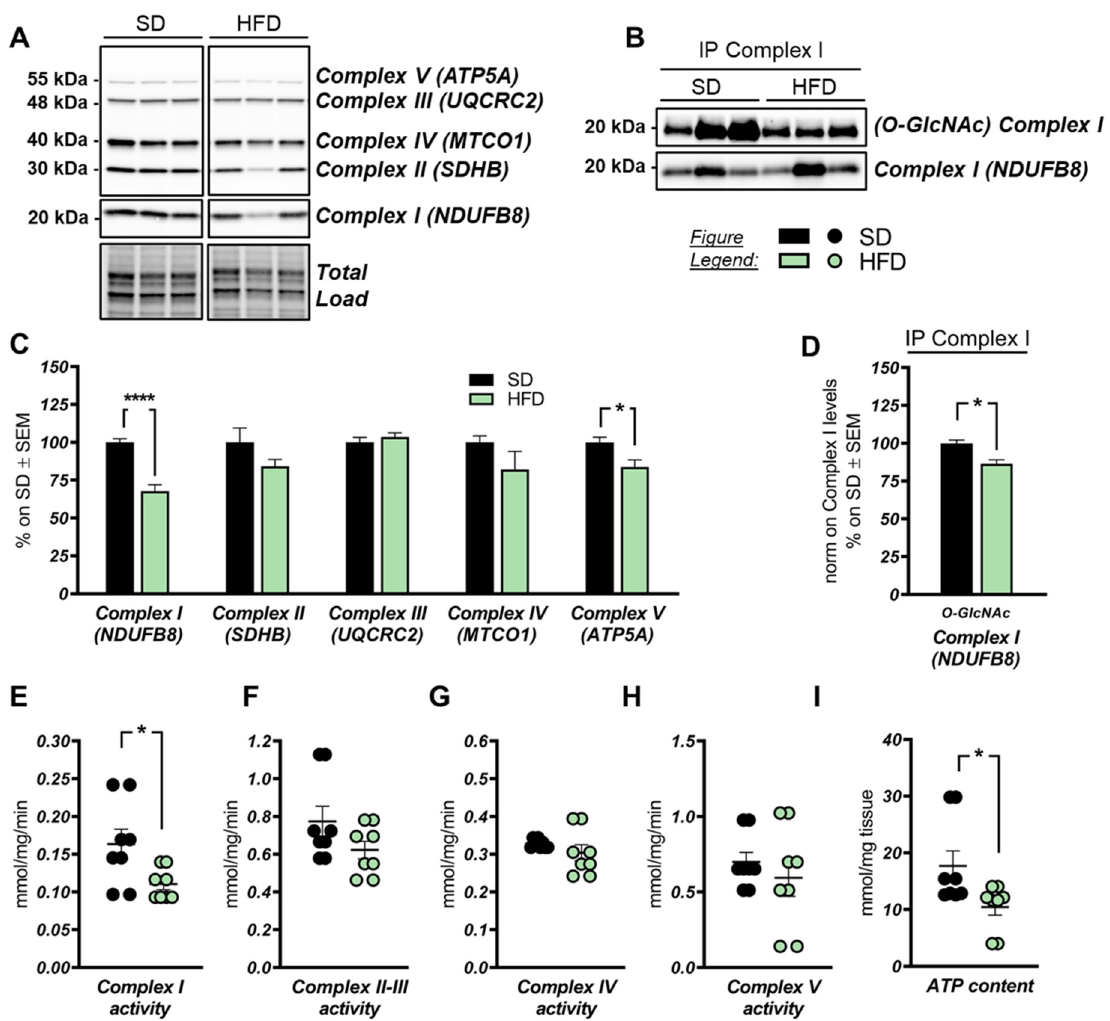
Figure 5. A high-fat diet affects respiratory chain complex expression and mitochondrial functionality. ( A , C ) Analysis of respiratory chain complex subunit expression in HFD-fed mice hippocampi compared to SD-fed animals. A significant reduction in Complex I subunit NDUFB8 was observed in HFD mice compared to SD controls. A trend of impairment was found for Complex II subunit SDHB and Complex IV subunit MTCO1 between HFD and respective controls, while no relevant changes have been observed in Complex III subunit UQCRC2 between the two groups of comparison. Finally, a significant decrease of Complex V subunit ATP5A expression was found in HFD-fed mice hippocampi in comparison to respective SD mice. Representative blots are reported in ( A ). ( B , D ) Analysis of Complex I subunit NDUFB8 O-GlcNAcylated levels by immunoprecipitation in HFD mice compared to controls. A significant reduction in O-GlcNAc NDUFB8 levels was observed in the hippocampus from HFD mice compared to respective SD-fed mice. Representative blots are reported in ( B ). ( E – H ) Evaluation of specific respiratory chain complex activity in HFD mice compared to controls. A significant reduction of Complex I activity was reported in HFD mice compared to SD animals ( E ). A trend of reduction was also observed in Complex II-III activity ( F ) and Complex V activity ( H ) in HFD mice compared to controls. I: Analysis of overall ATP content in HFD mice compared to correspondent SD animals. A relevant impairment of ATP content was observed in HFD animals compared to respective SD-fed mice. Number of animals for each condition were as follow: n = 6/group for Western blot analysis, n = 3/group for immunoprecipitation analysis, and n = 8/group for complex activity and ATP content evaluation. All bar charts reported in ( C – G ) and ( H , I ) show mean ± SEM. * p < 0.05 using Student’s t test.